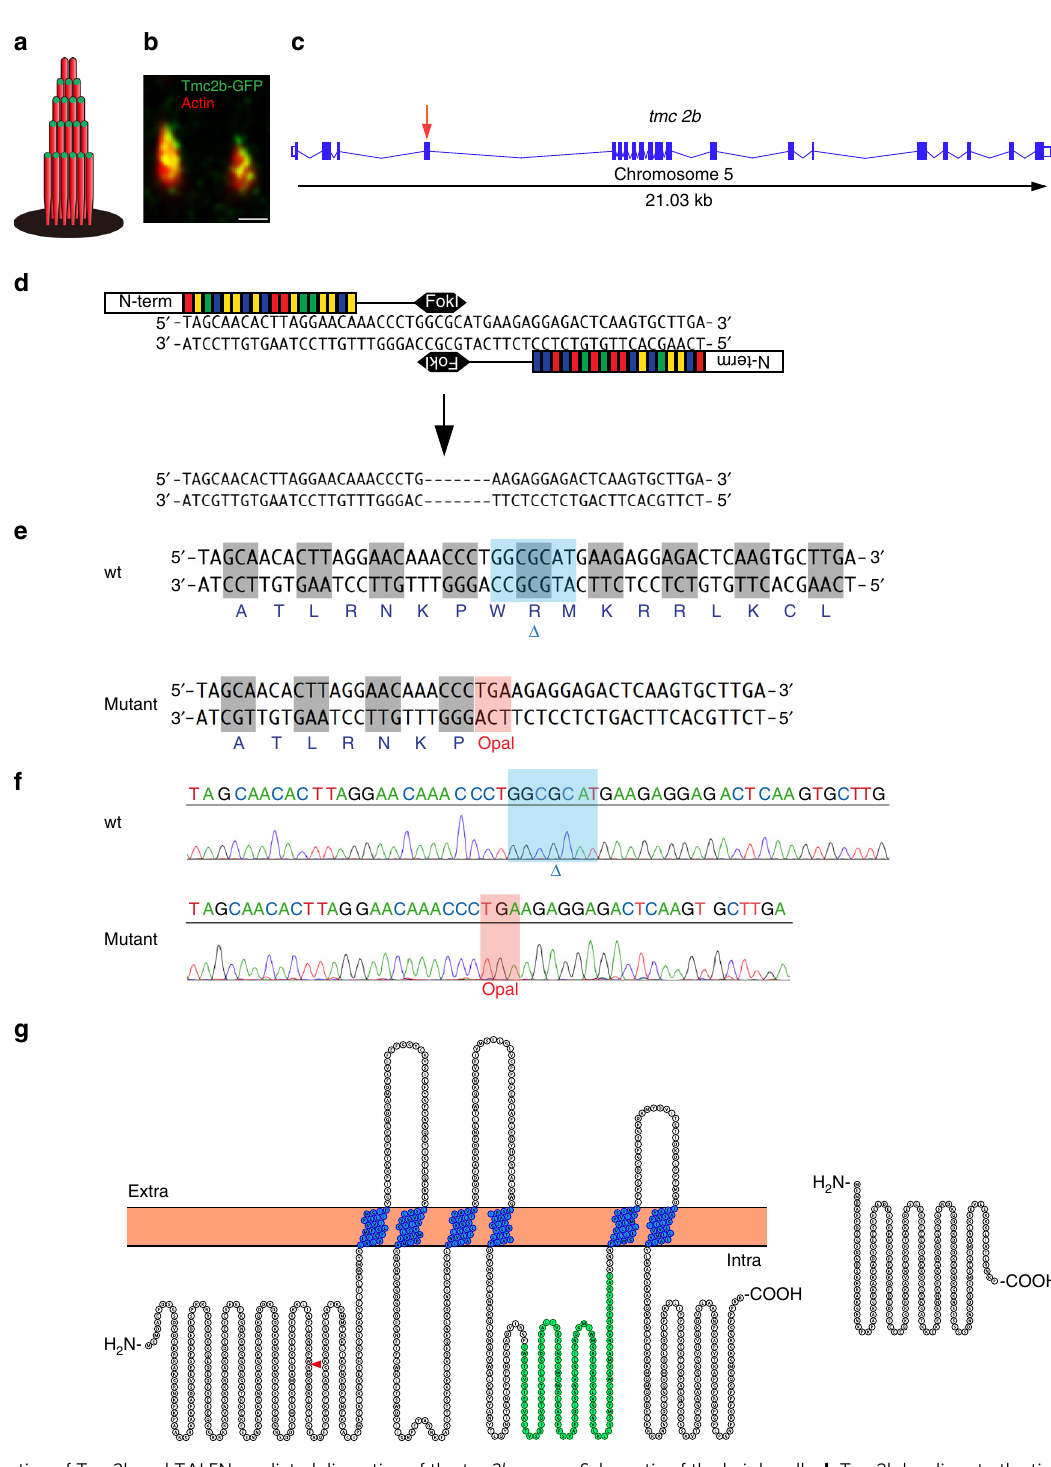
Fig. 2 Localization of Tmc2b and TALEN-mediated disruption of the tmc2b gene. a Schematic of the hair bundle. b Tmc2b localizes to the tips of stereocilia in a neuromast. Two lateral line hair cells expressing Tmc2b-GFP (green) demonstrate that the fusion protein localizes to the tips of β -actin-mCherry- labeled stereocilia (red). Scale bar = 0.5 μ m. This pattern was observed in 130 of 381 hair cells of somatic transgenics. In transgenic hair cells with weak expression, localization to stereocilia was dif fi cult to recognize. c Graphical representation of the tmc2b genomic locus in zebra fi sh. Putative exons and splice sites are displayed. Red arrow marks the targeted exon, exon 4. d Segment of exon 4 subjected to genome editing. Two differently engineered TALENs bind their corresponding half-sites to enable FokI dimerization and DNA cleavage. Mutagenesis deleted seven nucleotides. e Amino acid sequences of wild-type and mutant proteins. The alteration results in an opal mutation upstream of all putative transmembrane domains. f Sequencing results of mutagenized and control loci. Blue highlight and blue delta indicates deleted 7-nucleotide stretch absent in mutant. Red highlight denotes the opal mutation that was generated at the site of the TALEN targeting. g (left) Topographical representation of the Tmc2b protein. Red arrowhead indicates point of introduced mutation. Amino acids of putative transmembrane domains are labeled in blue and the TMC domain is in green. (right) Predicted